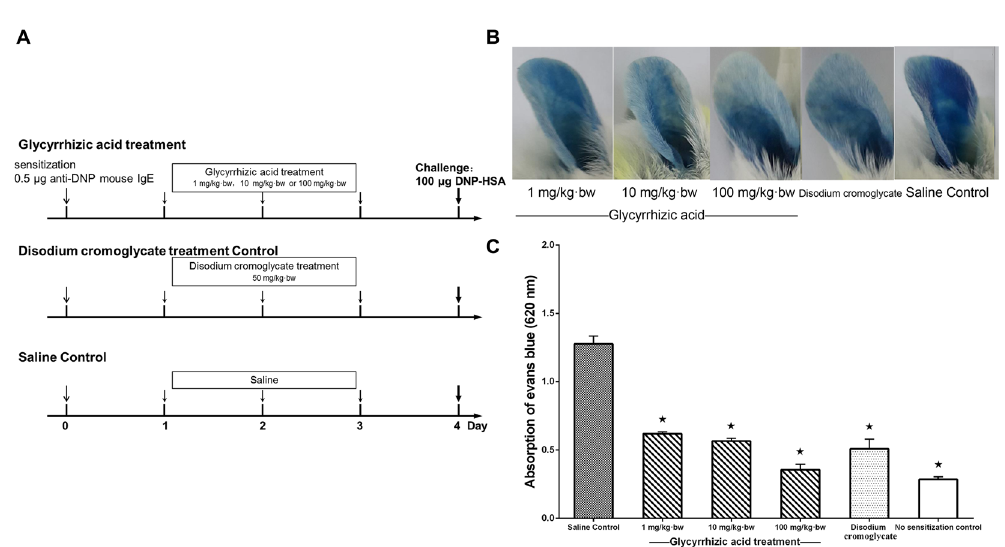
Figure 4. GA attenuated the vascular permeability by stabilizing mast cells. * P < 0.05 as compared to the saline control group (n = 5). ( A ) Schematic drawing representing the Balb/c mice passive cutaneous anaphylaxis protocols and doses used in this work. ( B ) Qualitative and ( C ) quantitative detection of the vascular permeability after Evan’s Blue Dye/DNP-HSA